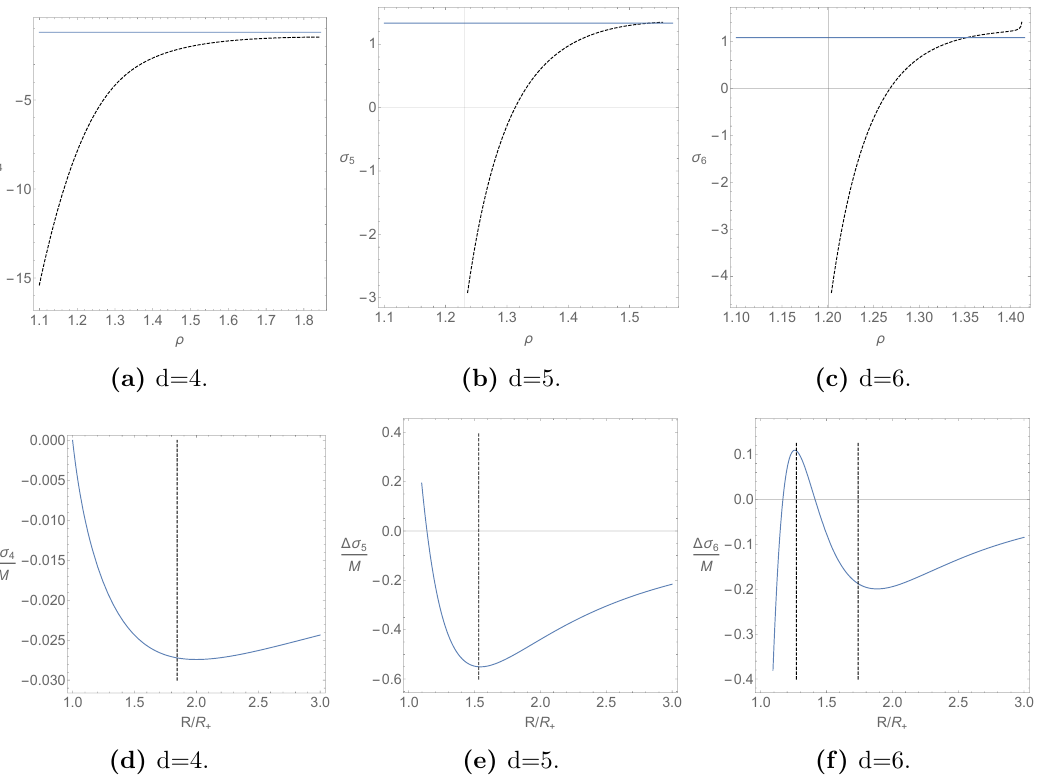
(d) d=4. Figure 10. In (a){(c), we plot the area of the minimal surfaces for boundary annuli as a function of the ratio of outer and inner radii (cid:26) = R 2 . The dotted line is the area for the \connected" surface R 1 while the (cid:12)lled line is the area for two \disconnected" balls. At some critical (cid:26) ( d ) (cid:3) the minimal area surface changes, representing a con(cid:12)ning phase transition. In (d){(f), we show the entanglement entropy of balls in the extremal black hole background (cid:1) (cid:27) d and mark (cid:26) ( d ) (cid:3) . In d = 6, the (cid:12)rst line marks radius where (cid:1) (cid:27) 6 is maximized and the second line is (cid:26) (6) (cid:3) times this